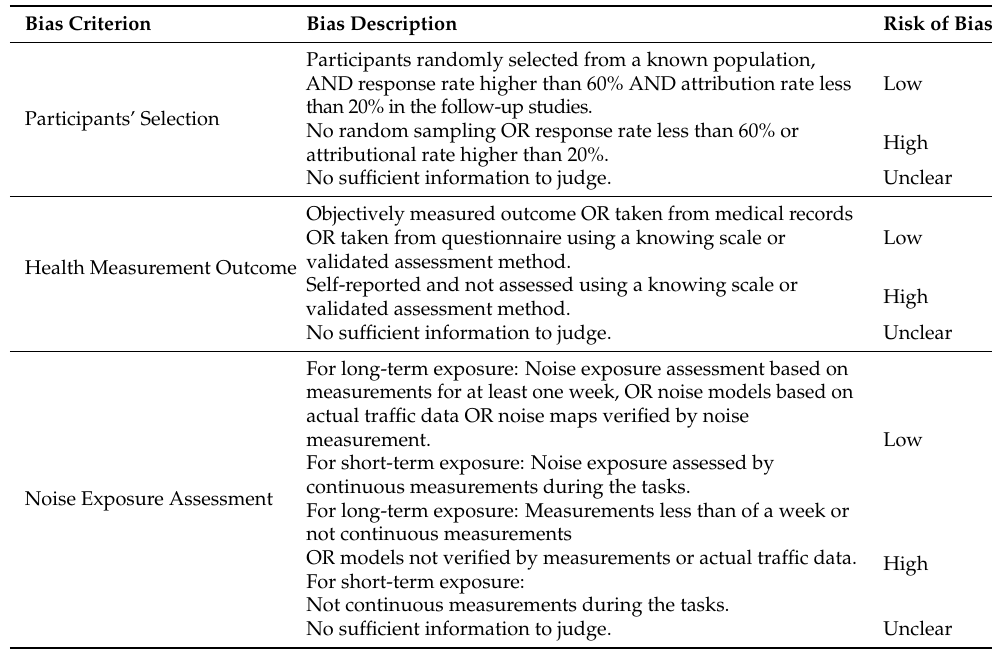
Table 3. Scoring protocol used to the assess the risk of bias in studies’